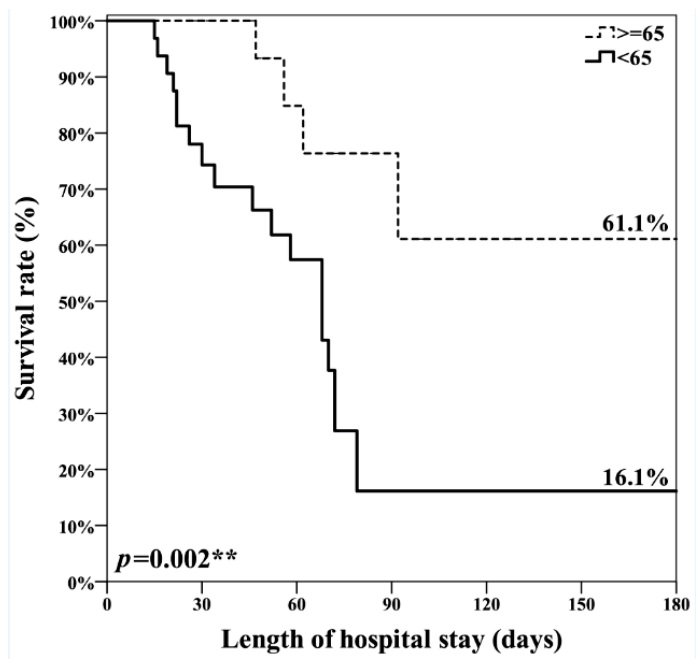
Figure 2. Energy achievement rate > 65% was significantly associated with lower 30-, 60-, and 90-day mortality in patients with high nutrition risk. ** p < 0.01.